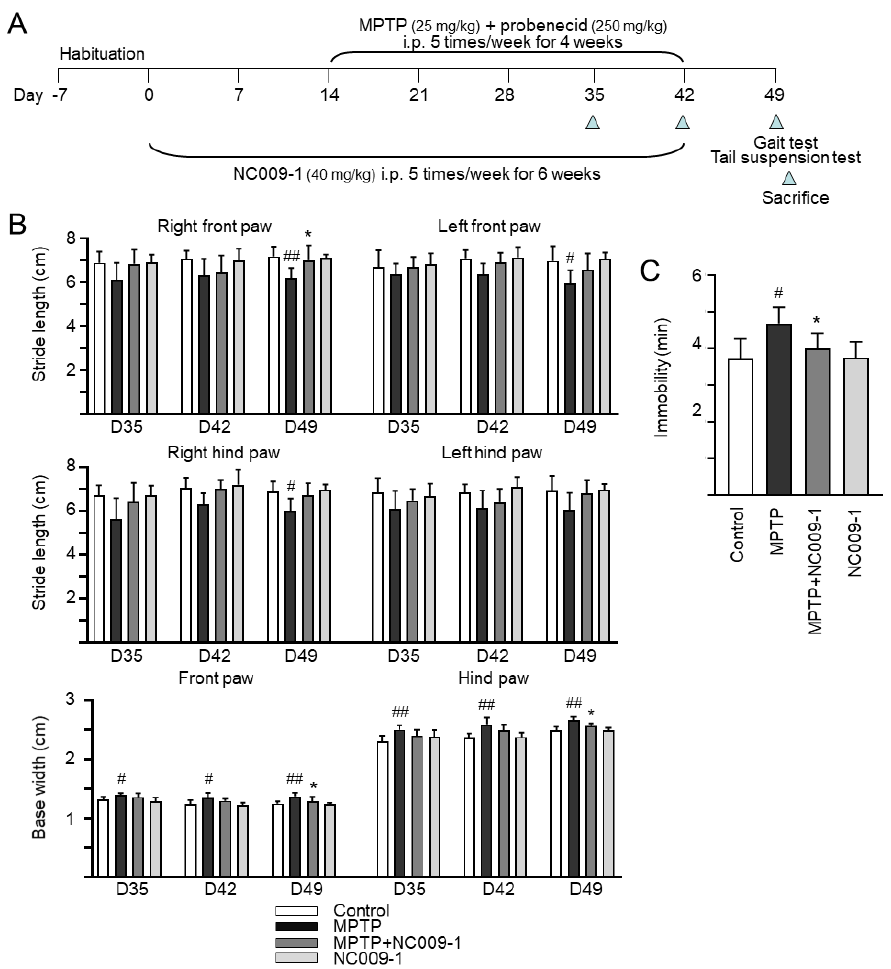
Figure 3. Neuroprotective effects of NC009 ‐ 1 in MPTP ‐ induced mouse model of PD. ( A ) Experimental protocol. After one week’s habituation, vehicle or NC009 ‐ 1 (40 mg/kg) was i.p. administrated into control and MPTP groups or NC009 ‐ 1 and MPTP+NC009 ‐ 1 groups ( n = 7) 5 times per week for 6 weeks. Two weeks after vehicle/NC009 ‐ 1 administration, MPTP and MPTP+NC009 ‐ 1 groups received i.p. injections of MPTP (25 mg/kg) along with probenecid (250 mg/kg) for 4 weeks (5 doses/week), while control and NC009 ‐ 1 groups received injections of saline. Mice were subjected to gait test on days 35, 42, and 49, and tail suspension test on day 49. Next day, mice were sacrificed for HPLC, IHC (Figure 4), and Western (Figure 5) analyses. ( B ) Gait test to assess gait variability. Stride length (right front paw, right hind paw, left front paw, and left hind paw) and base width (front paw and hind paw) were measured as the distance between two paw prints. ( C ) Tail suspension test to assess immobility. Duration of immobility within 6 min was recorded. ( B , C ), p values: comparisons between MPTP and control ( # p < 0.05, ## p < 0.01), or NC009 ‐ 1 ‐ treated and untreated MPTP mice (* p < 0.05).